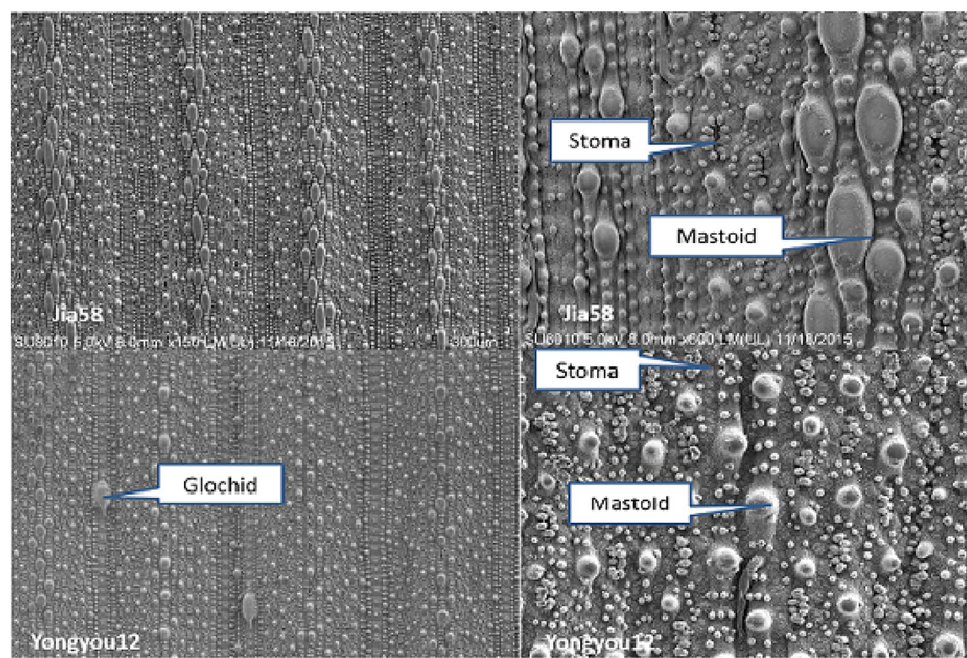
Figure 3. Scanning electron microscope(SEM)photos of two rice varieties. 100 μm and 50 μm are mage scale, is under 3000 times and 6000 times the